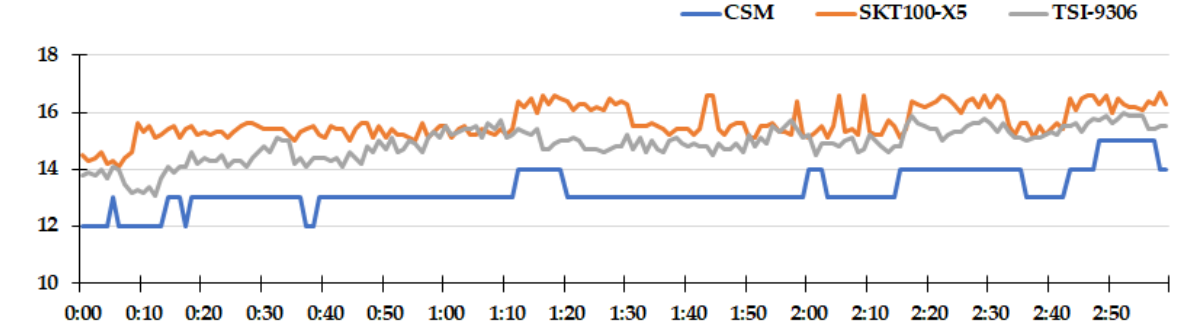
Figure 3. Number of PM2.5 particles over time.